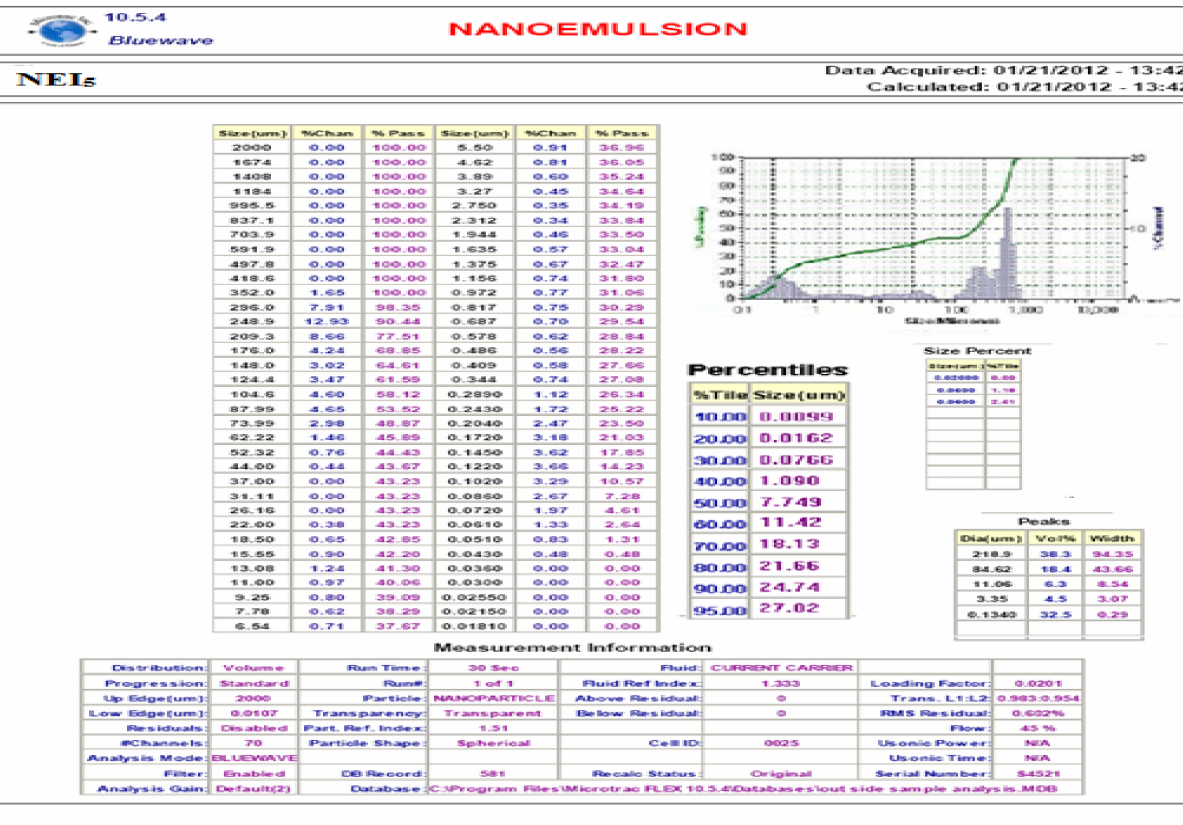
Figure 2. Particle size analysis.